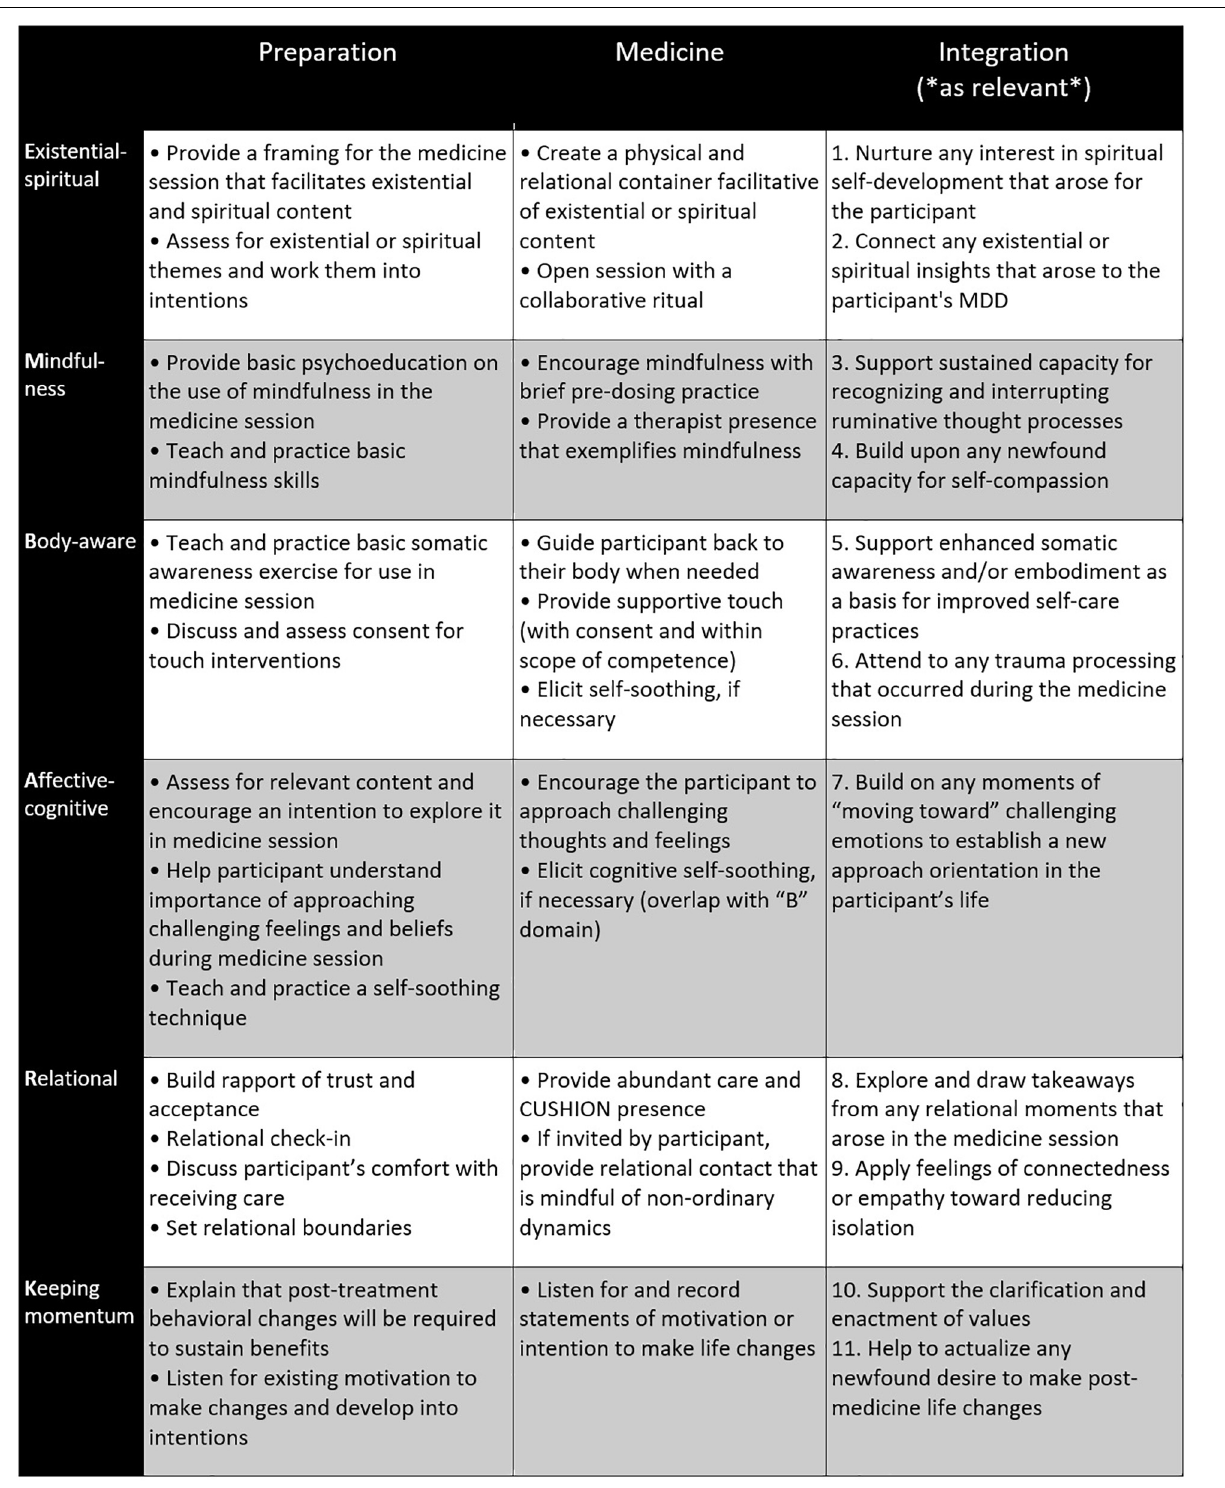
Frontiers in Psychology |